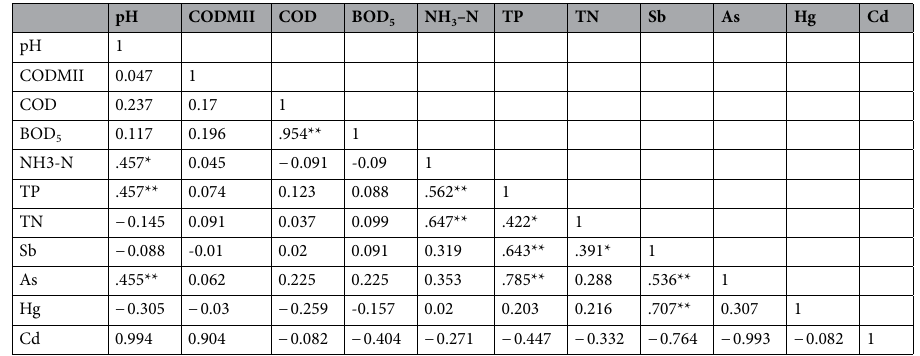
Table 3. Pearson correlation coefficients of the water quality indices and heavy metal concentrations in the surface water in XKS. *At level 0.05 (two-tailed), the correlation was significant. **At level 0.01 (two–tailed), the correlation was significant.